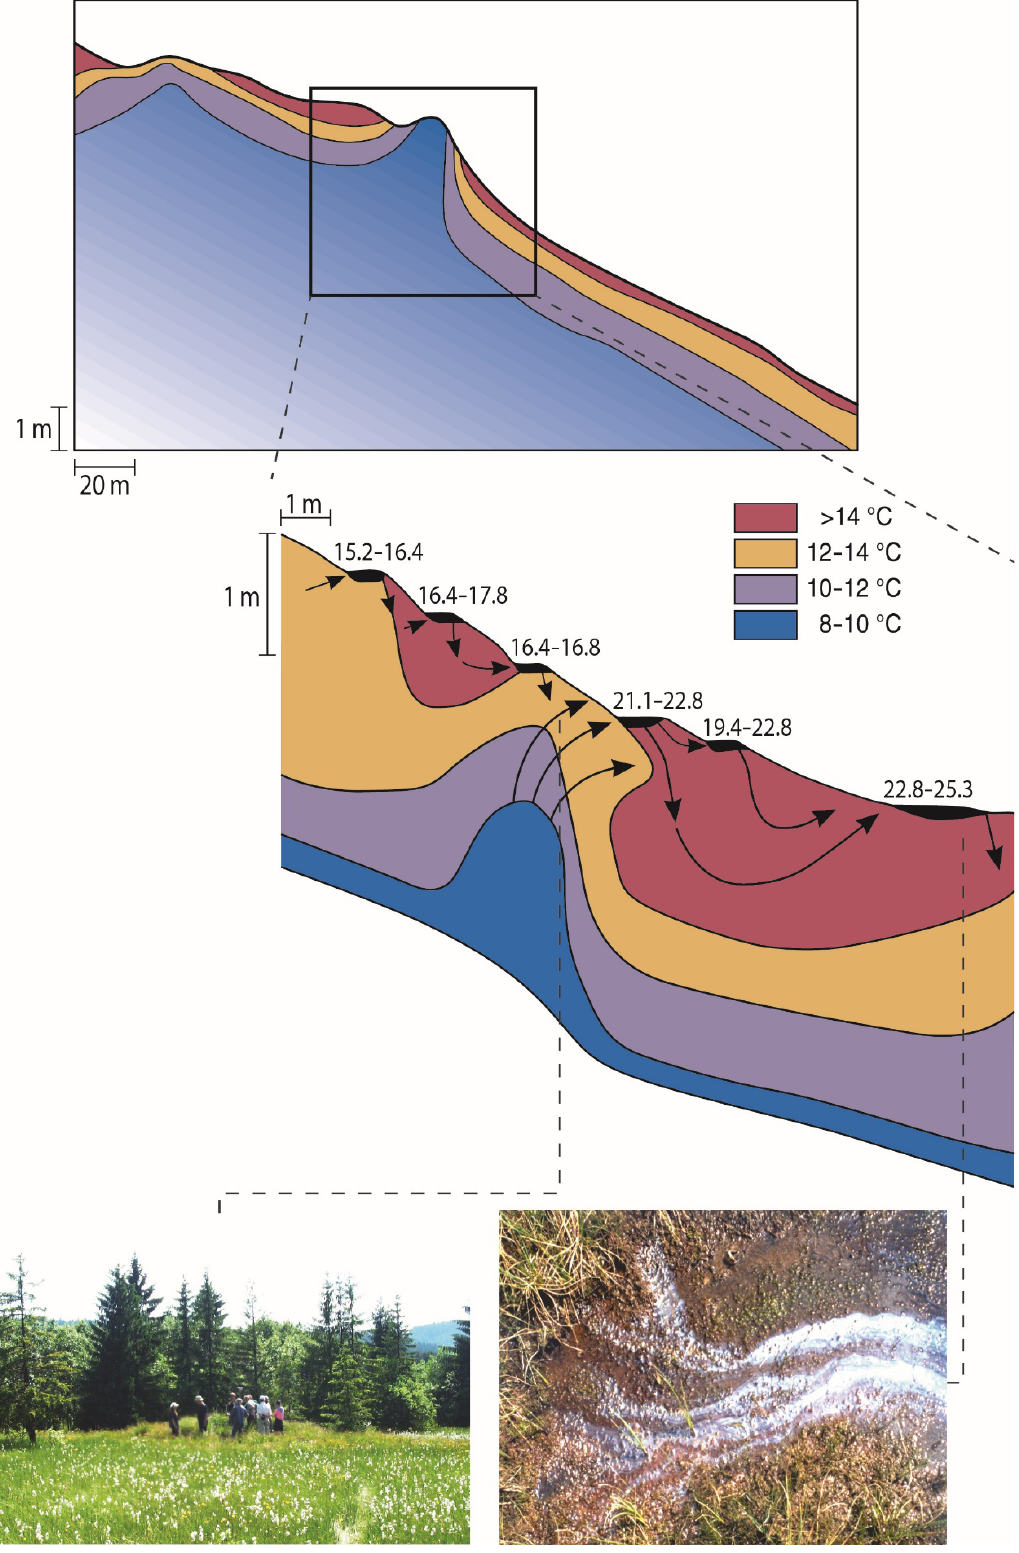
Figure 5. Temperature profiles in the Brezové mire (Slovakia), indicating the groundwater flow from a spring to a cascade of small pools (black) in which precipitation of tufa occurs. The left-hand photo shows people standing on the main spring cupola with Eriophorum latifolium in the foreground on the sloping mire. The right-hand photo shows that iron rich seepage water (with an iridescent surface bacterial film) is flowing through a small pool (after Grootjans et al .